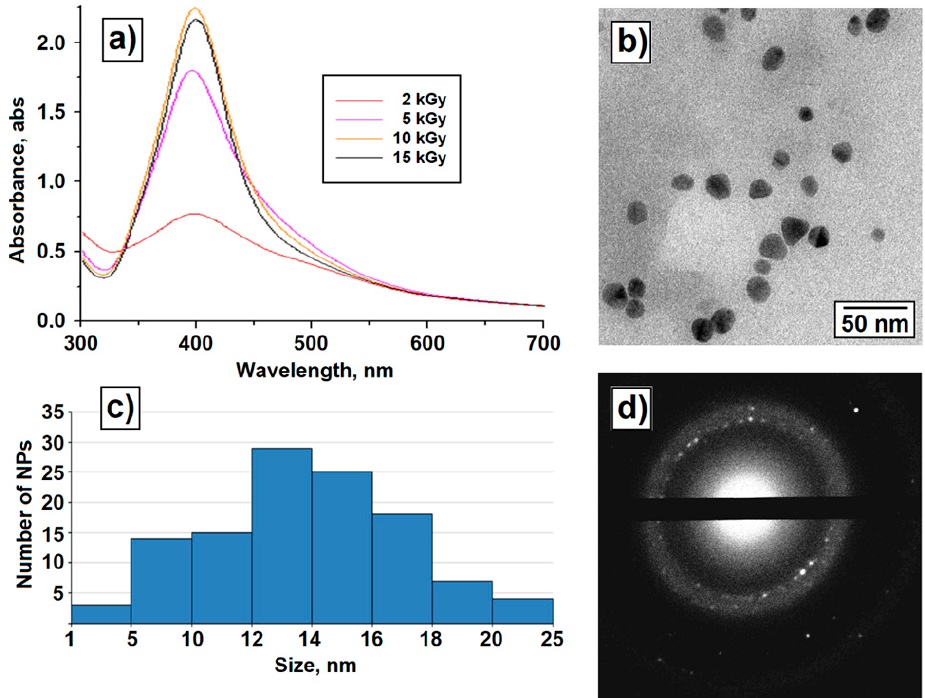
Figure 4. UV–visible spectra ( a ), micrography ( b ), histogram of the size distribution of nanoparticles ( c ), microdiffraction image ( d ) of irradiated PAA–Ag + complexes.